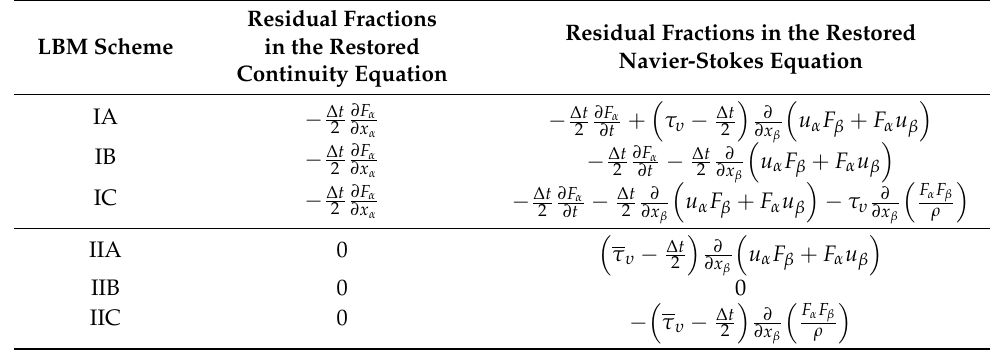
Table 2. The captured residual fractions in the recovered continuity and Navier-Stokes equations from every considered LBM